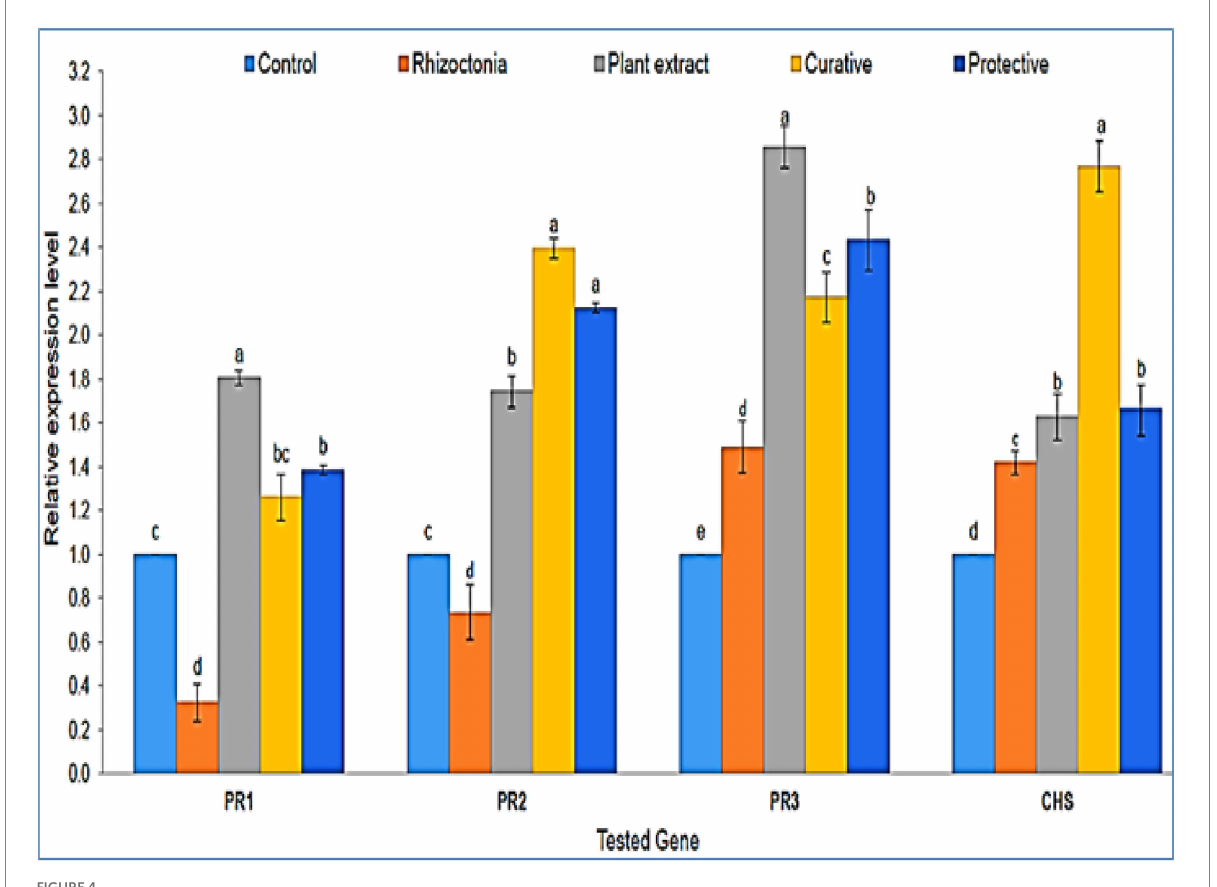
FIGURE 4 A histogram shows the relative expression levels of the four genes PR-1 , PR-2 , PR-3 , and CHS at 20 dpi of plant extract treatments (100 μ g/ml) in different treatments compared with control. The different letters (a–e) represent significant differences.